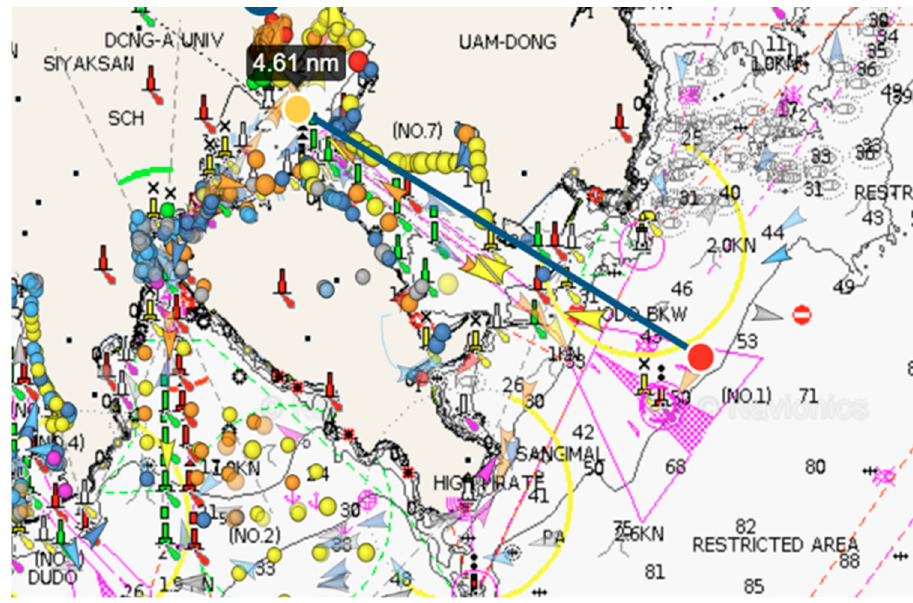
Figure 4. Maneuvering distance (Pilot station to Port) [26].